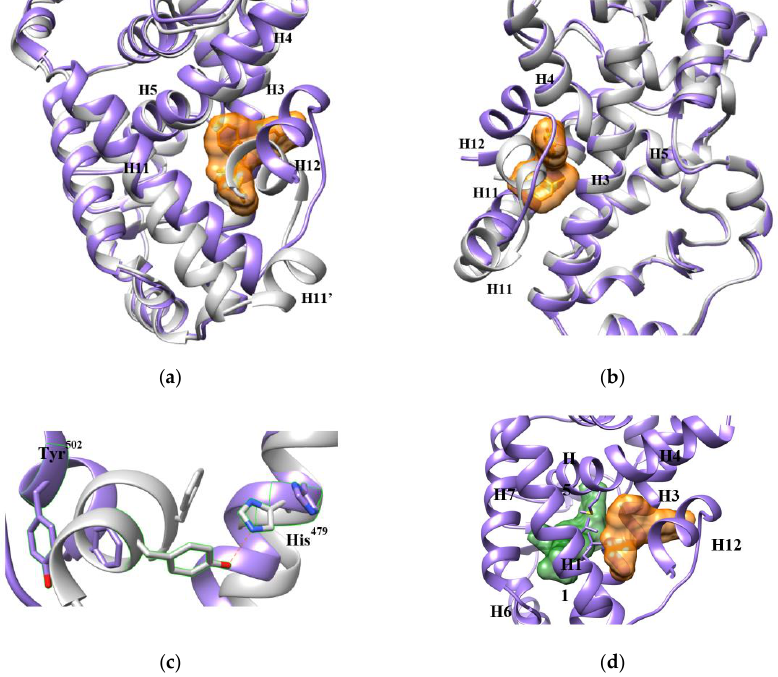
Figure 8. An allosteric inverse agonist 1 binds in the AF-2 binding pocket. The structure of ROR γ LBD bound with 1 (orange surface) is presented in purple (PDB 4YPQ), while the apo LBD is in grey. ( a , b ) Two views of the pocket from di ff erent orientations display the movement of the helices. Especially, 1 partially occupies the space of H12 and forces it to shift away from other helices. ( c ) A ff ected by 1 , Tyr 502 is pushed to a position too far away from His 479 to maintain the agonist lock. ( d ) The AF-2 site is adjacent to the orthosteric site (green) with a short tunnel connecting them, which is surrounded by hydrophobic residues shown in sticks. The orthosteric site is demonstrated with an orthosteric inverse agonist from PDB